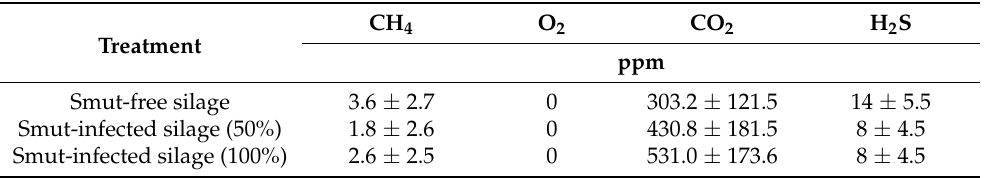
Table 3. Concentrations of gases in silage affected with different Ustilago maydis infection rates (measured after 90 days of ensiling). CH 4 O 2 CO Treatment